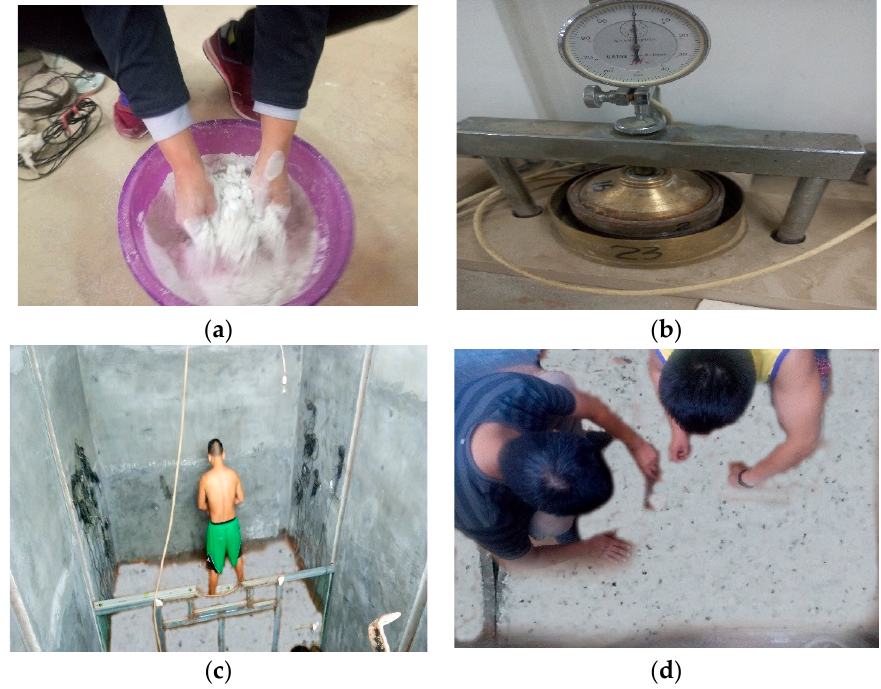
Figure 3. Fabrication of surrounding rock: ( a ) Production of mixture; ( b ) Collapsibility test; ( c ) Compaction process; ( d ) Sampling.